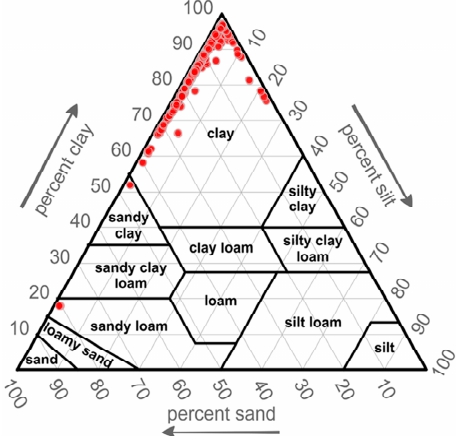
Figure 6. Texture of the studied soil samples. The size of the soil particles was divided into clay ( ≤ 2